Question: According to the figure, is the described quantity increasing or decreasing?
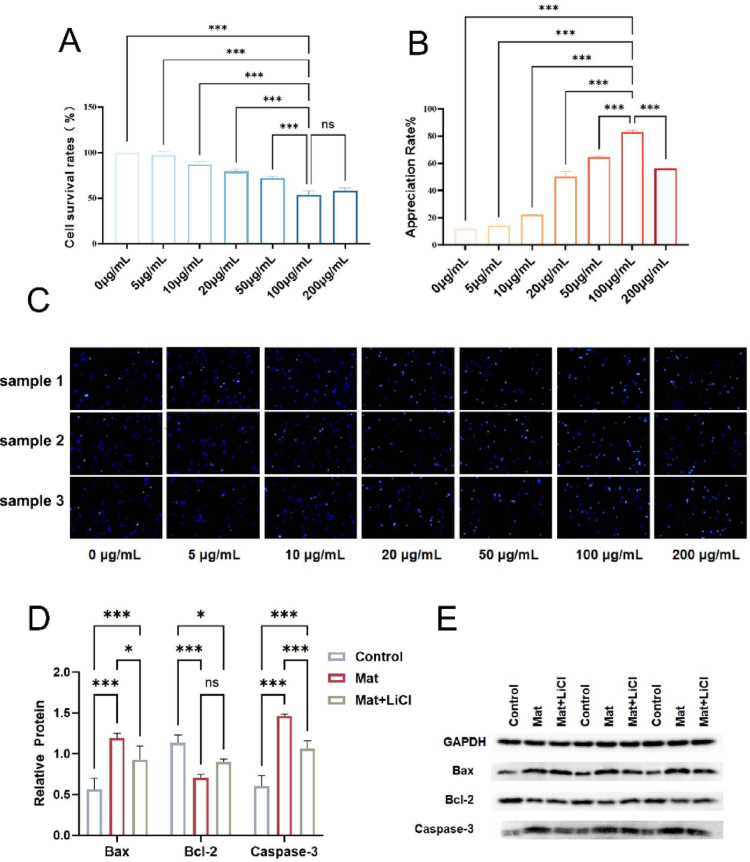
Answer: decreasing